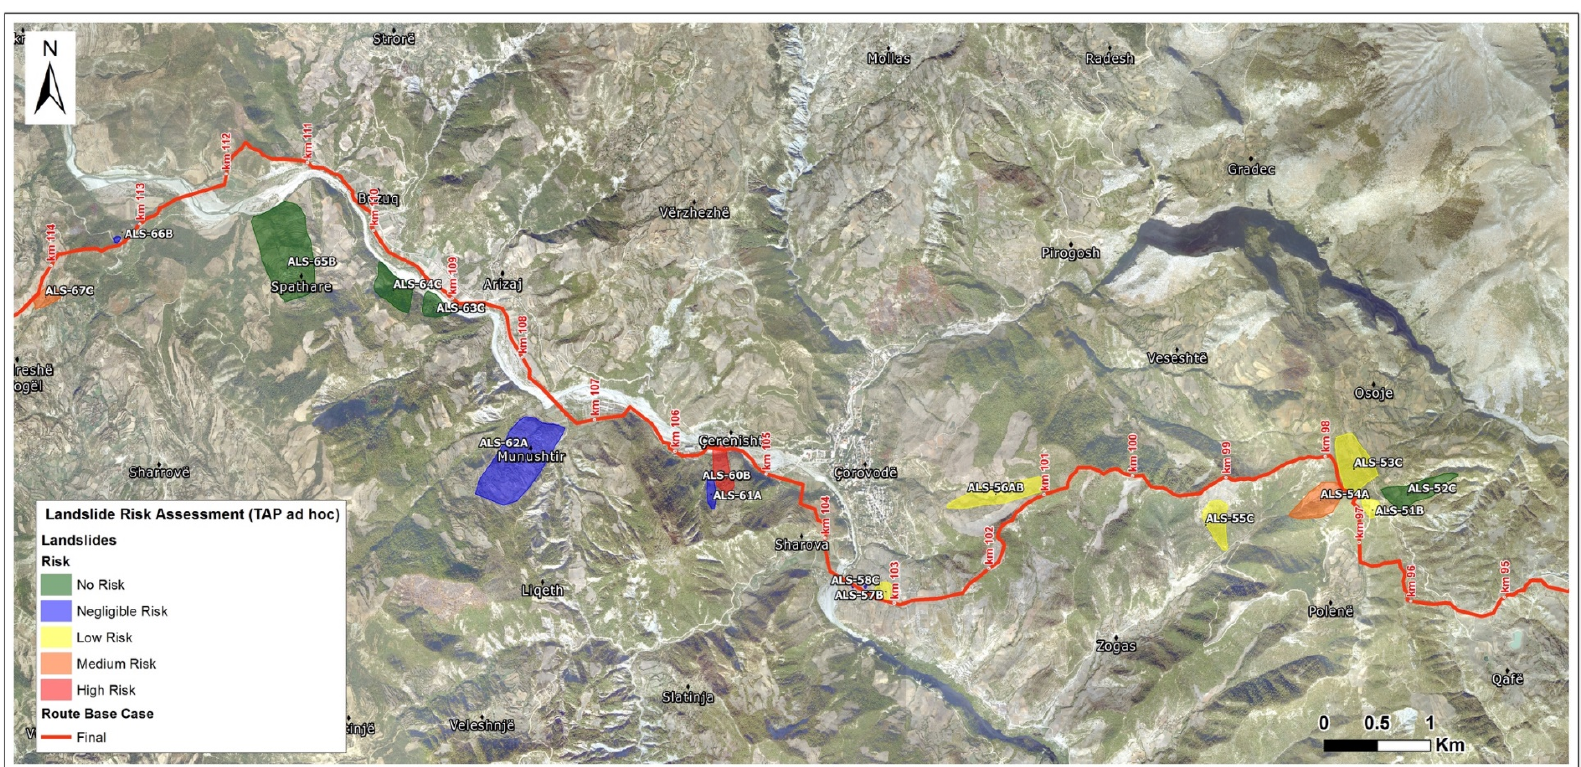
Figure 18. Landslide risk assessment results for the pipeline route from approximately 95 to 114 km. The later presented example of landslide ALS-60B is shown at the central part of the map (105–106 km).